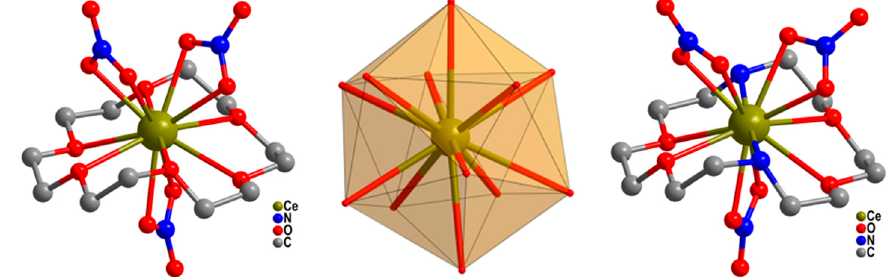
Figure 25. Molecular structure of 41 ( left ); Icosahedron coordination geometry around the Ce(III) ion ( middle ); and molecular structure of 44 ( right ). The structures are re-drawn from Reference [63] with permission from the American Chemical Society © 2016.